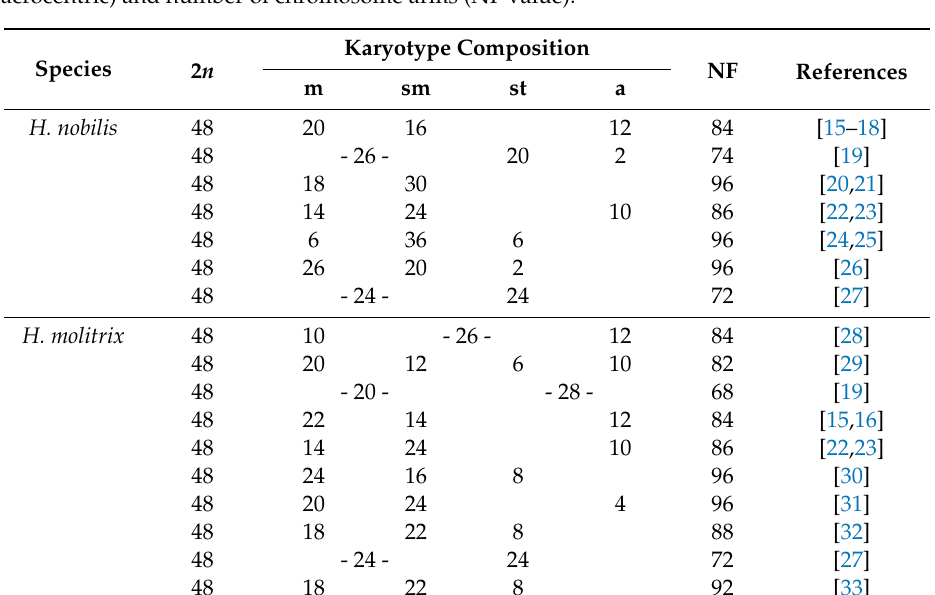
Table 1. Summary of reported data on diploid chromosome number (2 n ), numbers of chromosomes in particular morphological categories (m—metacentric, sm—submetacentric, st—subtelocentric, a—acrocentric) and number of chromosome arms (NF